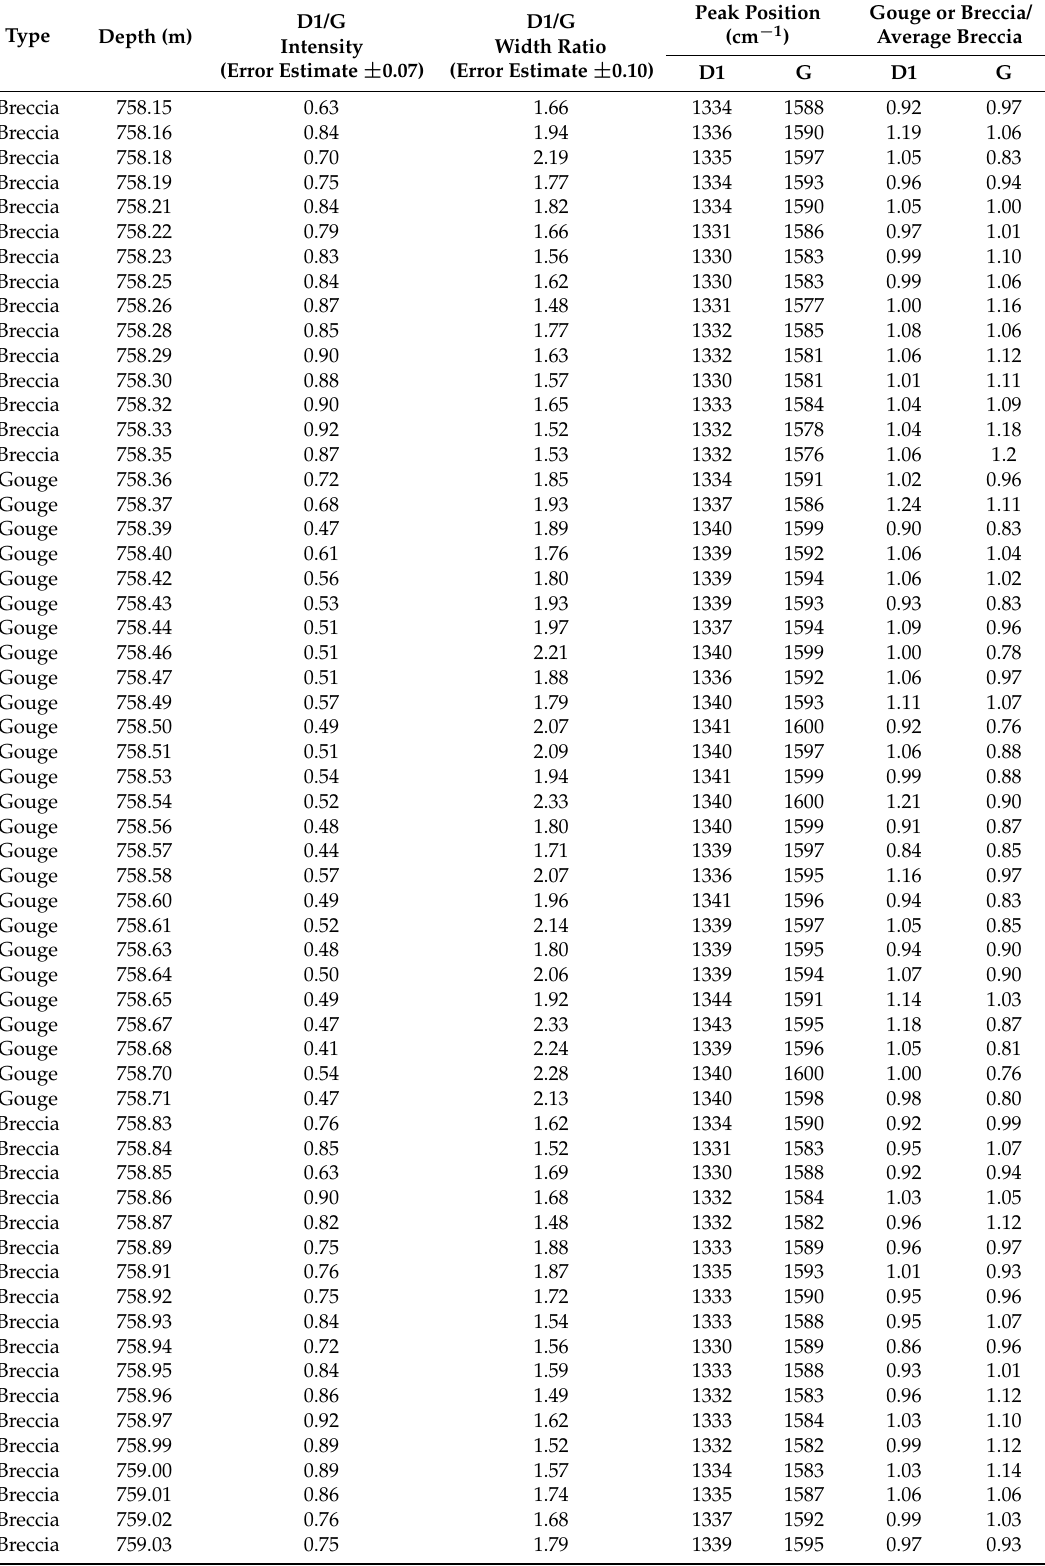
Table 1. Spectra decomposition on Raman results of FZ760 from WFSD-1